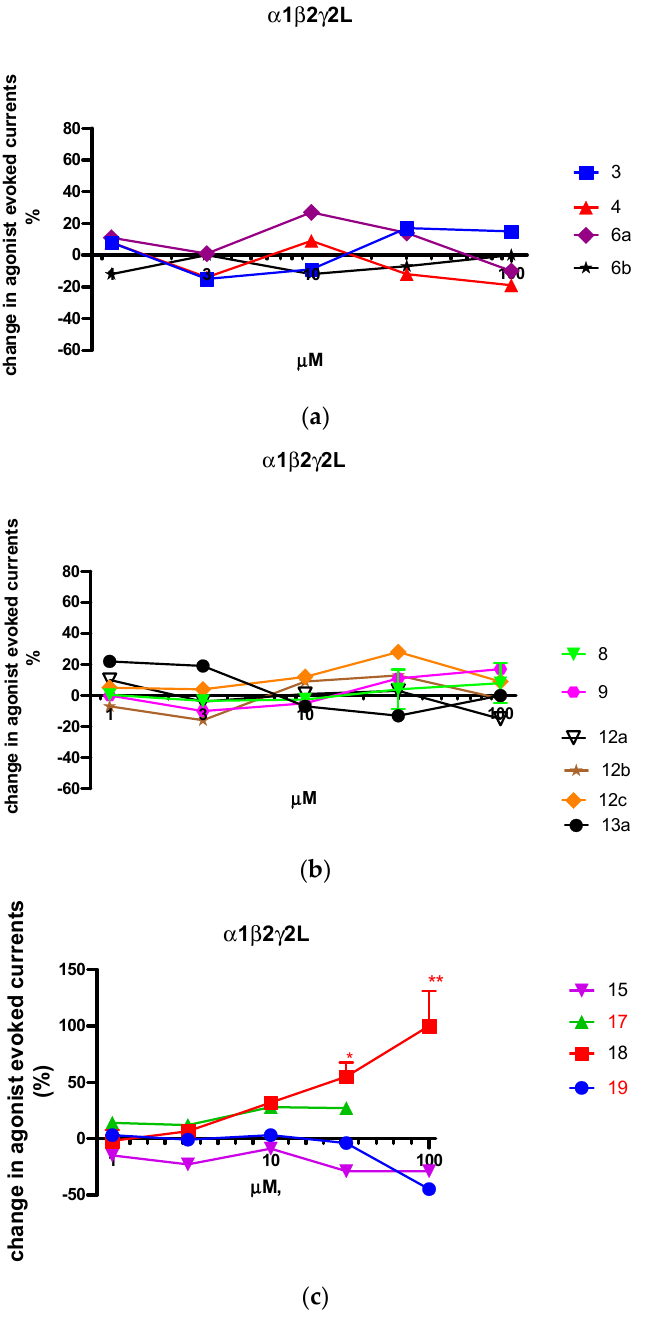
Figure 6. Concentration-response curves of compounds 3 , 4 , 6a , b , 8 , 9 , 12a – c , 13a (panel ( a , b )) and 15 , 17 – 19 (panel ( c )) on GABA-induced Cl − currents in Xenopus laevis oocytes expressing recombinant α 1 β 2 γ 2L-GABA A receptors. Data are expressed as the percentage modulation of the response induced by GABA at EC 5-10 values (approximatively 3–5 µ M) and are the mean ± SEM of values obtained from two to nine oocytes.* p < 0.05; ** p <